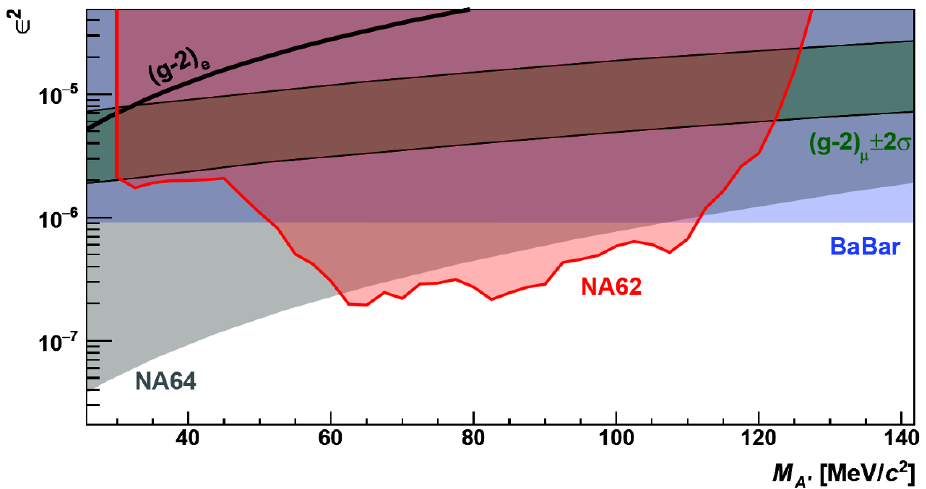
Figure 7 . Upper limit at 90% CL from NA62 (red region) in the (cid:15) 2 vs M A 0 plane with A 0 decaying into invisible (cid:12)nal states. The limits from the BaBar [8] (blue) and NA64 [9] (light grey) experiments are shown. The green band shows the region of the parameter space corresponding to an explanation of the discrepancy between the measured [11] and expected values of the anomalous muon magnetic moment ( g (cid:0) 2) (cid:22) [12] in terms of a contribution from the A 0 in the quantum loops [13, 14]. The region above the black line is excluded by the agreement of the anomalous magnetic moment of the electron ( g (cid:0) 2) e with its expected value